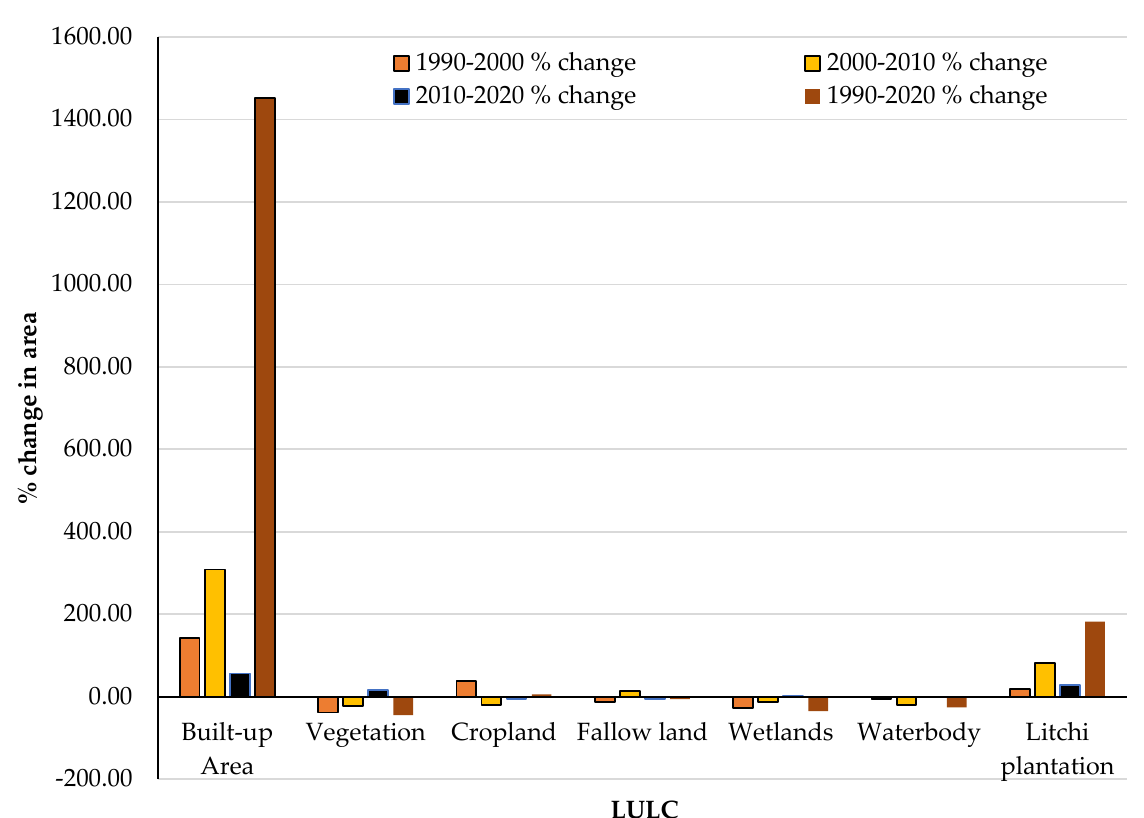
Figure 6. Comparative % area change estimates of different LULC classes from 1990–2020.